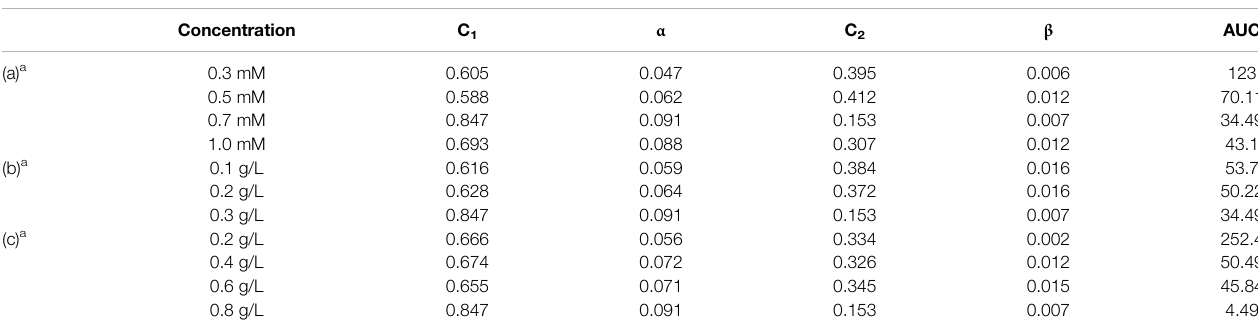
TABLE 4 | Comparative list of kinetic parameters for APAP degradation using different concentrations of (A) Fe 2+ ; (B) CuO catalyst; and (C) PS. Concentration C 1 α C 2 β AUC (a)